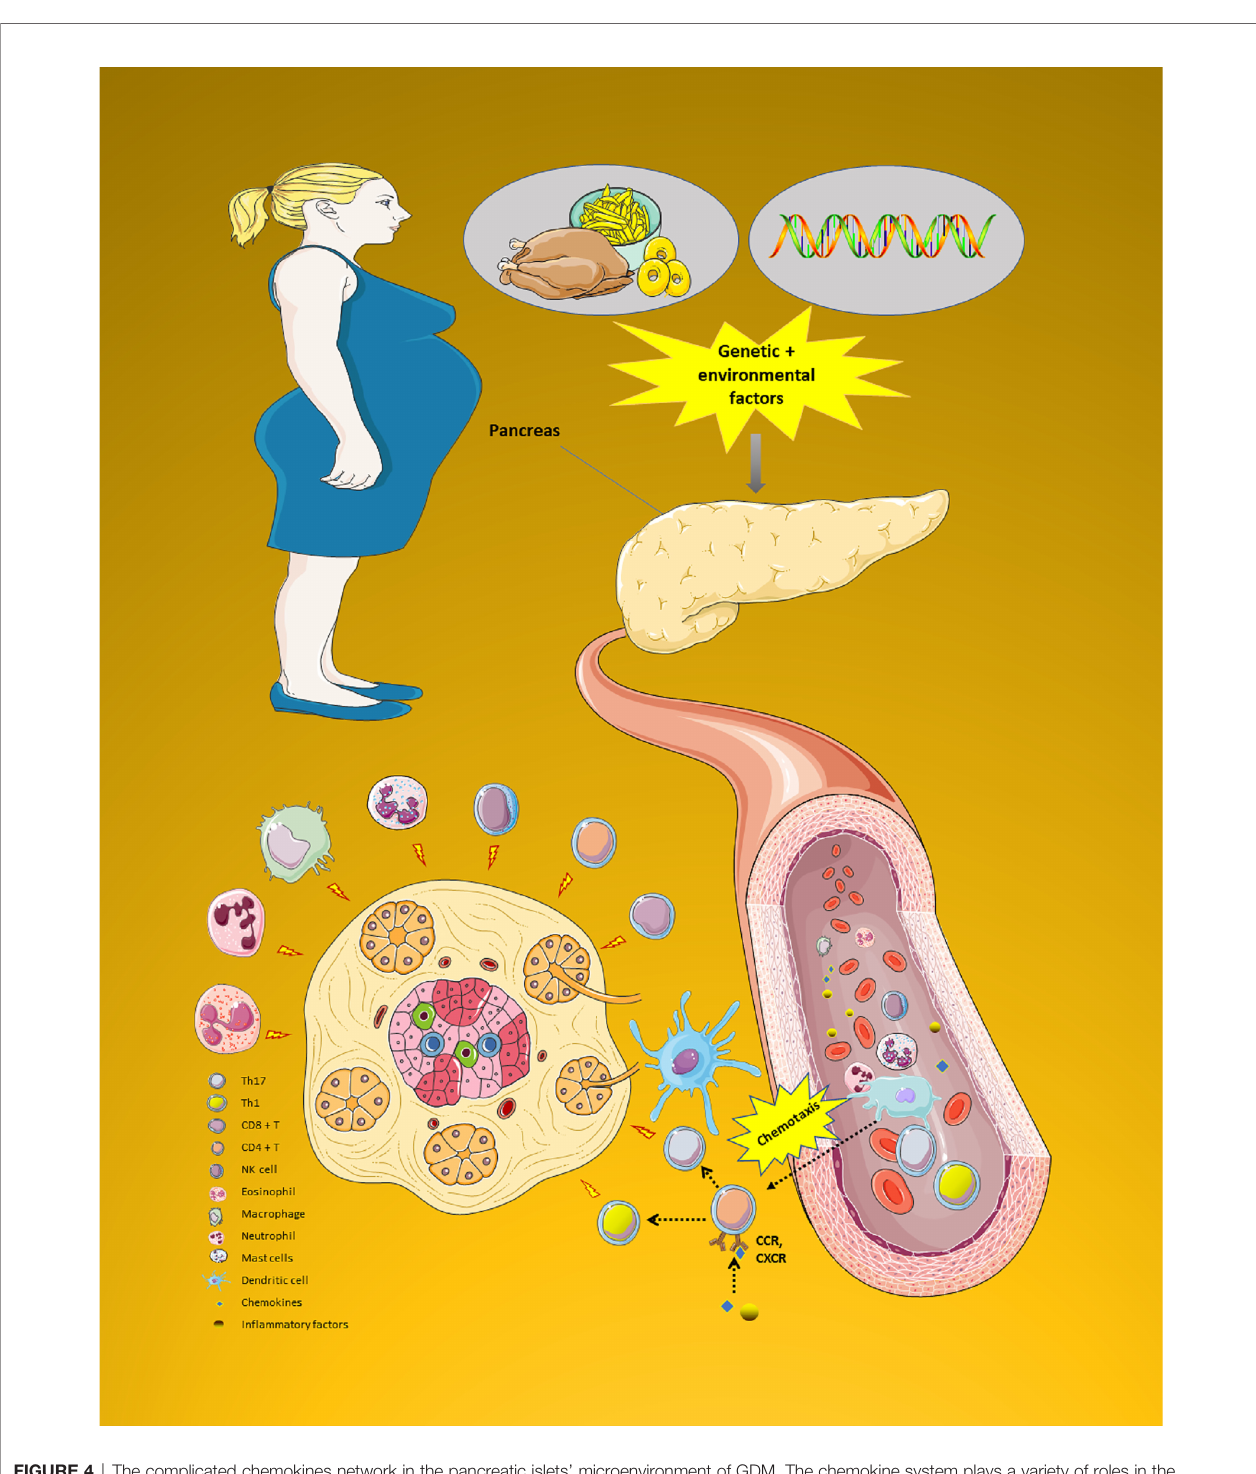
FIGURE 4 | The complicated chemokines network in the pancreatic islets ’ microenvironment of GDM. The chemokine system plays a variety of roles in the pancreatic islets microenvironment of GDM. First, pancreatic islets are exposed to an early damage by genetic or environmental factors. Then, chemokines can also cause a variety of immune cells to enter the pancreatic islets site to play the role of immune attack. All these processes impact endoplasmic reticulum stress, leading to a reduction in the ability to secrete insulin. Moreover, GDM progression is characterized by progressive secretion of pro-in fl ammatory chemokines/cytokines caused by b cell damage. Due to this process, various immune cell types (i.e., CD8+T cell, CD4+T cell (Th1 cell and Th17 cell), NK cell, eosinophil, macrophage, neutrophil, mast cells, and dendritic cell) are recruited in the pancreatic tissue. These immune cells further release more innate in fl ammatory cytokines, which contribute to a rapid increase b cell death. GDM, Gestational diabetes mellitus; NK, Natural killer. (Drawn by